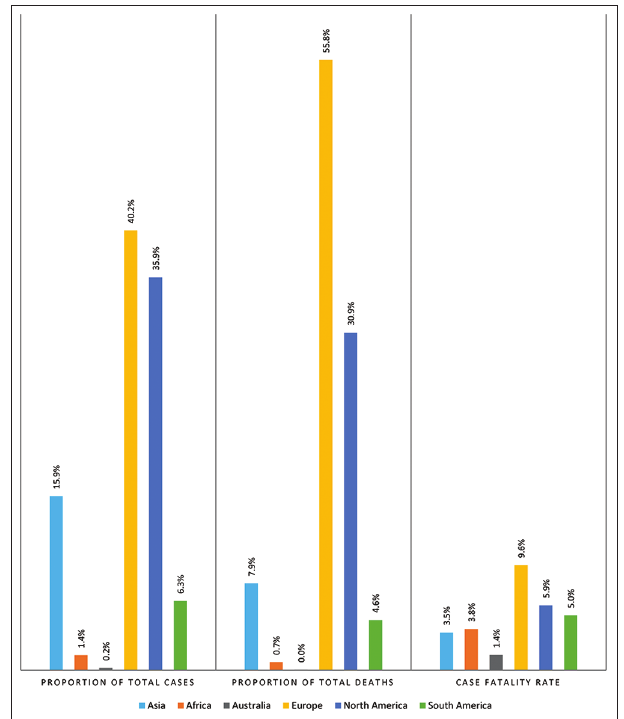
Figure 1: COVID-19 cases, deaths and case fatality rate by